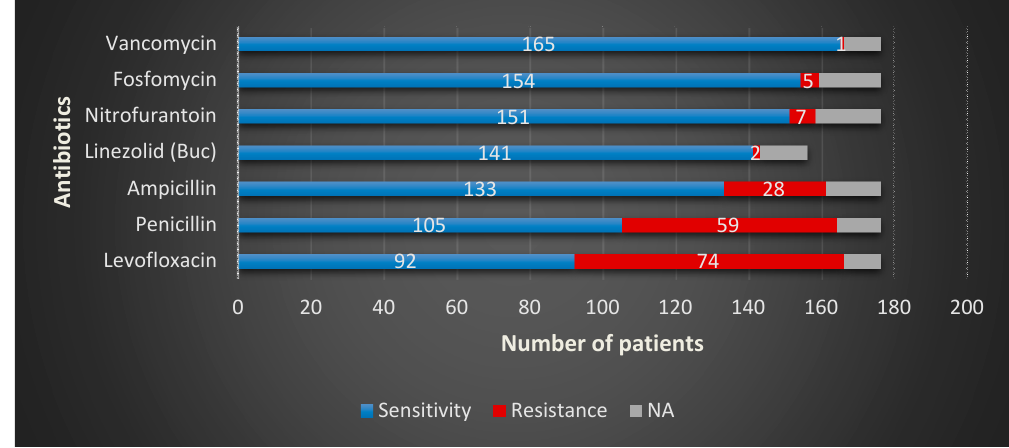
Figure 5. Enterococcus spp. overall sensitivity and resistance profiles in the study group.